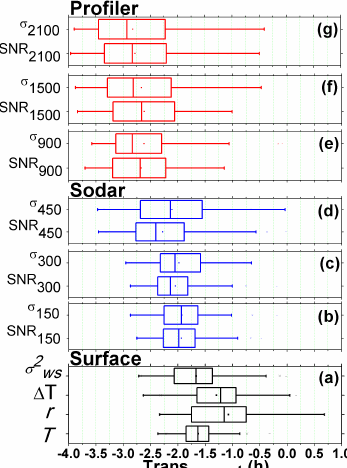
Figure 3. Distributions (in terms of boxplot) of Trans sunset ( = start time of AT – time of sunset) for different state variables, depict- ing the behavior of the transition start time with reference to the sunset time. Distributions for Trans sunset at (a) the surface (ob- ) , (b – d) 150, 300 and 450m, re- tained from T , r , (cid:49)T and σ 2 WS spectively (obtained from sodar-derived range-corrected SNR and σ) and (e – g) 900, 1500 and 2100m, respectively (obtained from profiler-derived range-corrected SNR and σ)